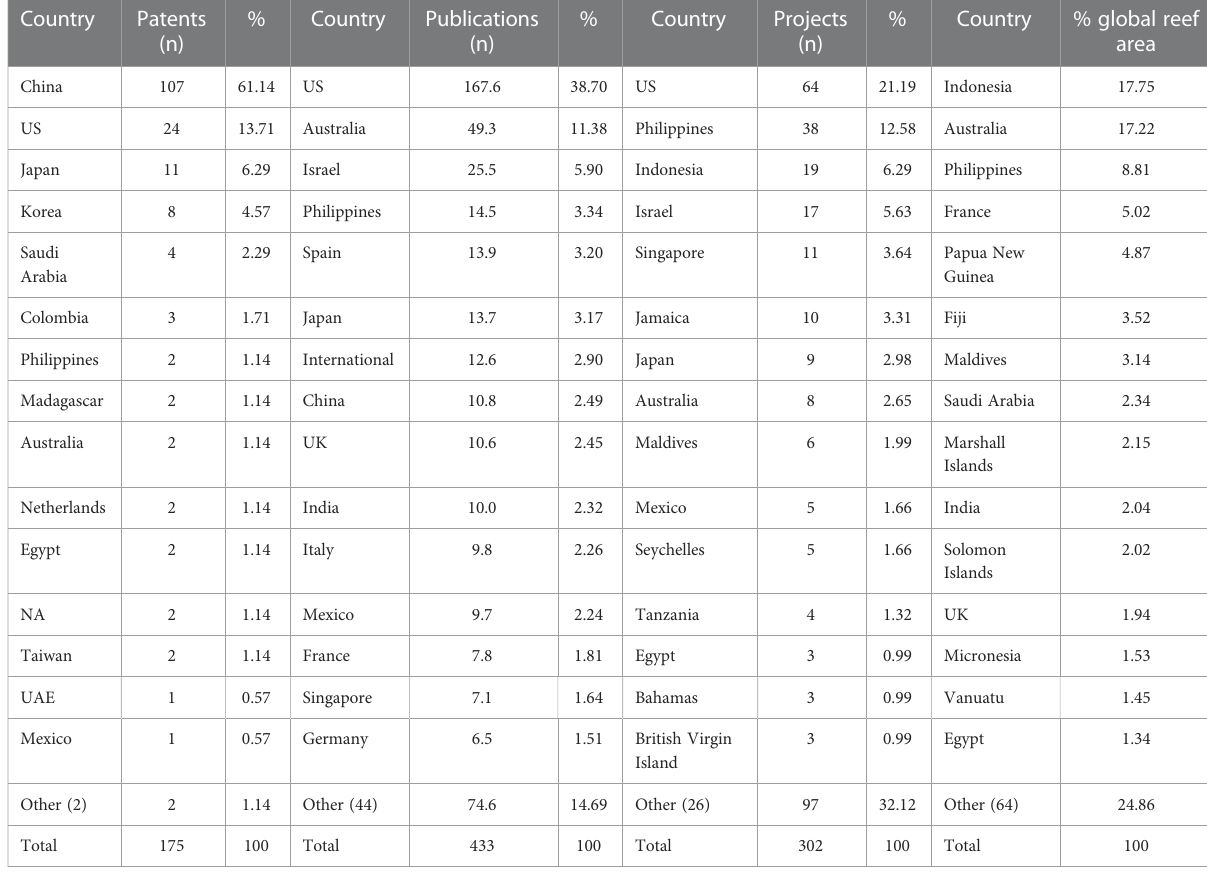
TABLE 1 Geographic distribution of patent fi lings, scienti fi c publications, restoration projects, and reef area.